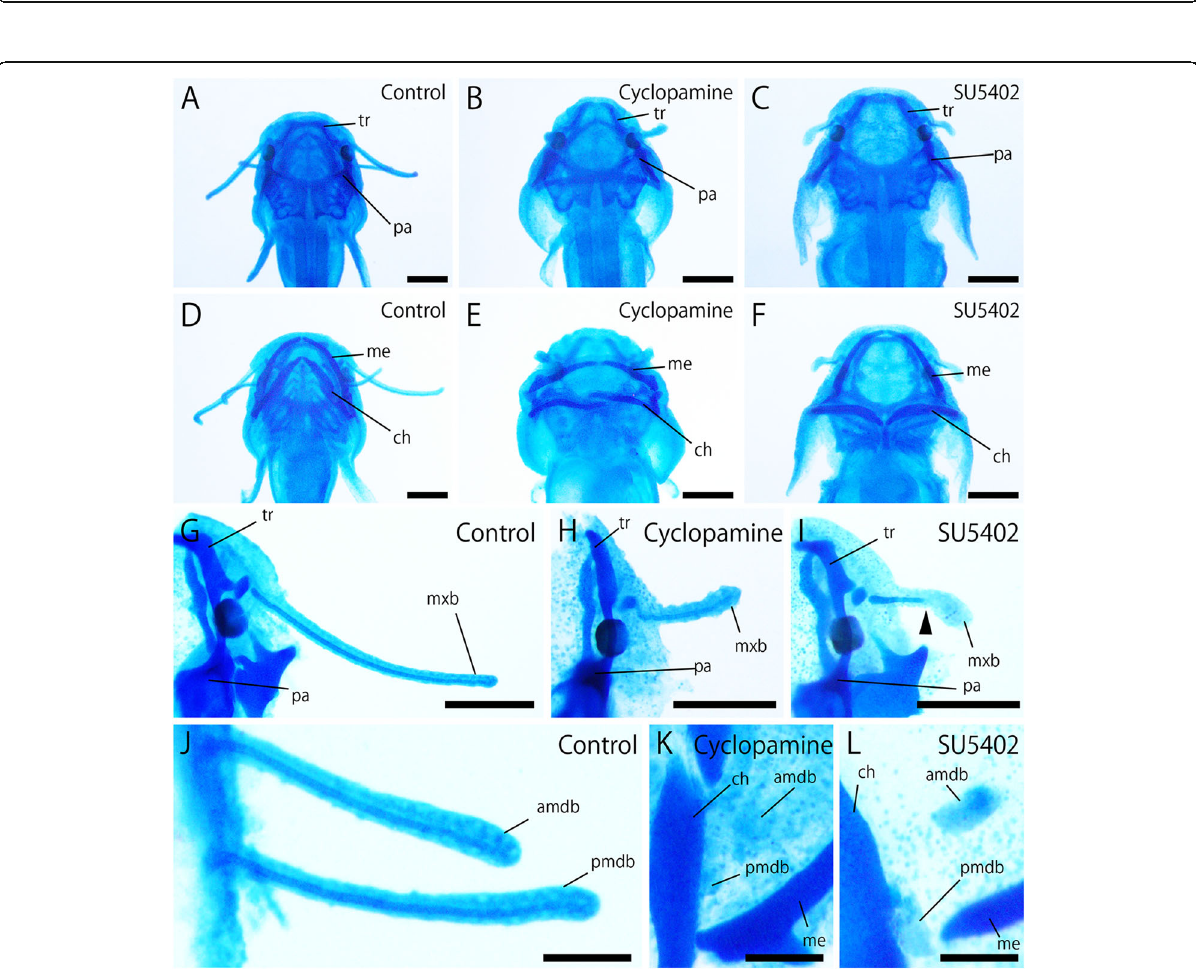
Fig. 9 Effects of SHH and FGF signal inhibitors on cartilage formation. a – f , dorsal ( a – c ) and ventral ( d – f ) views of control ( a , d ), cyclopamine- treated ( b , e ), and SU5402-treated ( c , f ) embryos at 5 dpf. Inhibition of SHH caused malformation of trabecular (tr), parachordal (pa), Meckel ’ s (me), and ceratohyal (ch) cartilages ( b , e ). Inhibition of FGFs causes malformation of ceratohyal cartilage (ch), while other craniofacial cartilages appear unaffected ( c , f ). g – l , dorsal ( g – i ) and ventral ( j – l ) views of control ( g , j ), cyclopamine-treated ( h , k ), and SU5402-treated ( i , l ) embryos at 5 dpf. Cartilages in maxillary ( g – i ) and mandibular ( j – l ) barbels were visualized by Alcian blue. The cartilages of cyclopamine-treated embryos entered into the maxillary barbel and extended to the tip of the barbel, consistent with the control group ( h ), although they became thinner compared with the controls ( g ). In the mandibular region, the barbel cartilage was absent in cyclopamine-treaed group ( k ). FGF inhibition caused reduction in cartilage length in the maxillary barbel (arrowhead in i ). In the mandibular region, barbel cartilages were severely reduced ( l ). amdb, anterior mandibular barbel; ch, ceratohyal cartilage; me, Meckel ’ s cartilage; mxb, maxillary barbel; pa, parachordal cartilage; pmdb, posterior mandibular barbel; tr, trabecular cartilage. Anterior is the upper side in all images and the proximal side is left in g – l . Scale bars in a – i are 500 μ m and 200 μ m in j – l